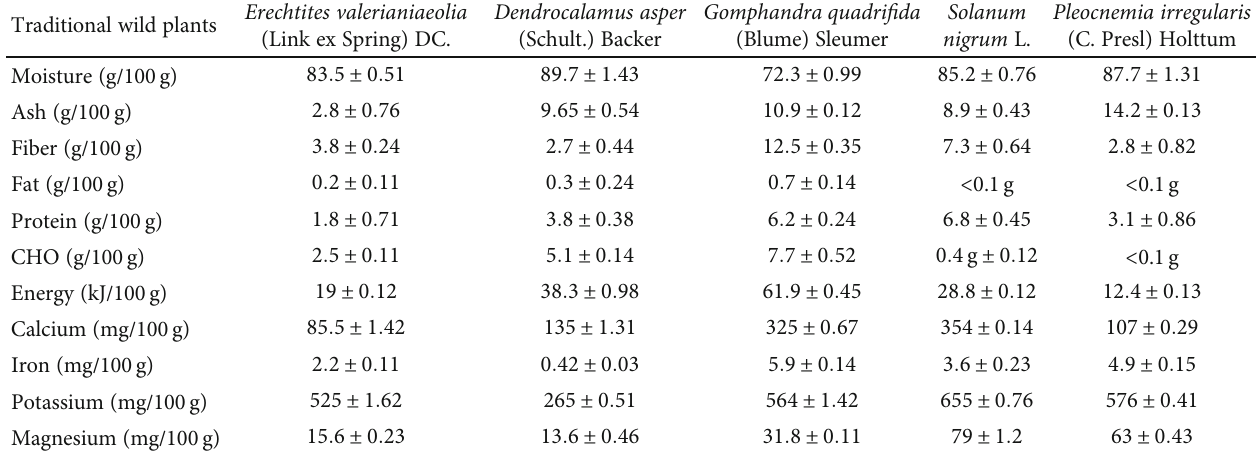
Table 2: Proximate composition (g/100 g), energy (kcal/100 g), and minerals and trace minerals (mg/100g) of four di ff erent species of edible wild vegetables and its Recommended Dietary Allowance (source: [25]). Traditional wild plants (Link ex Spring)